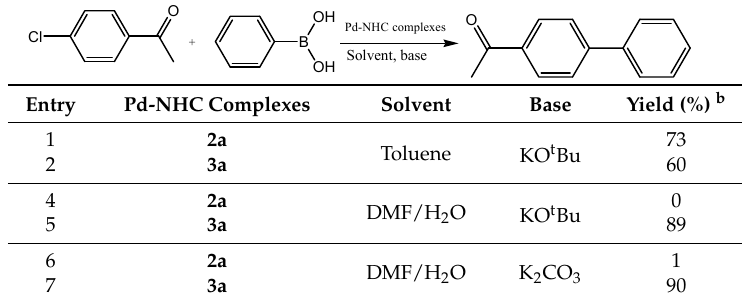
Molecules 2017 , 22 , 420